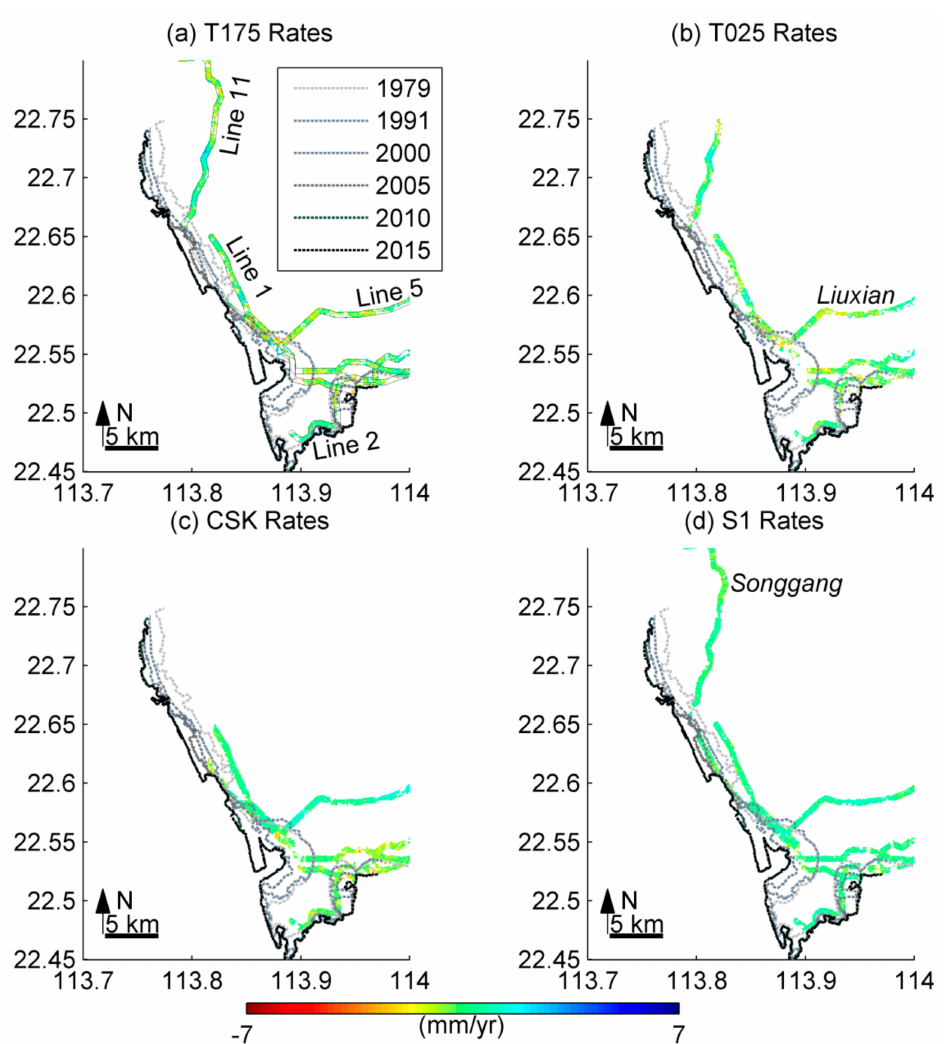
Figure 12. ( a ) Mean rates along subways in Shenzhen from ASAR T175 (21 November 2004–4 April 2010) with buffer distance of 250 m to both sides of subway Line 1, Line 2, Line 5 and Line 11; ( b – d )